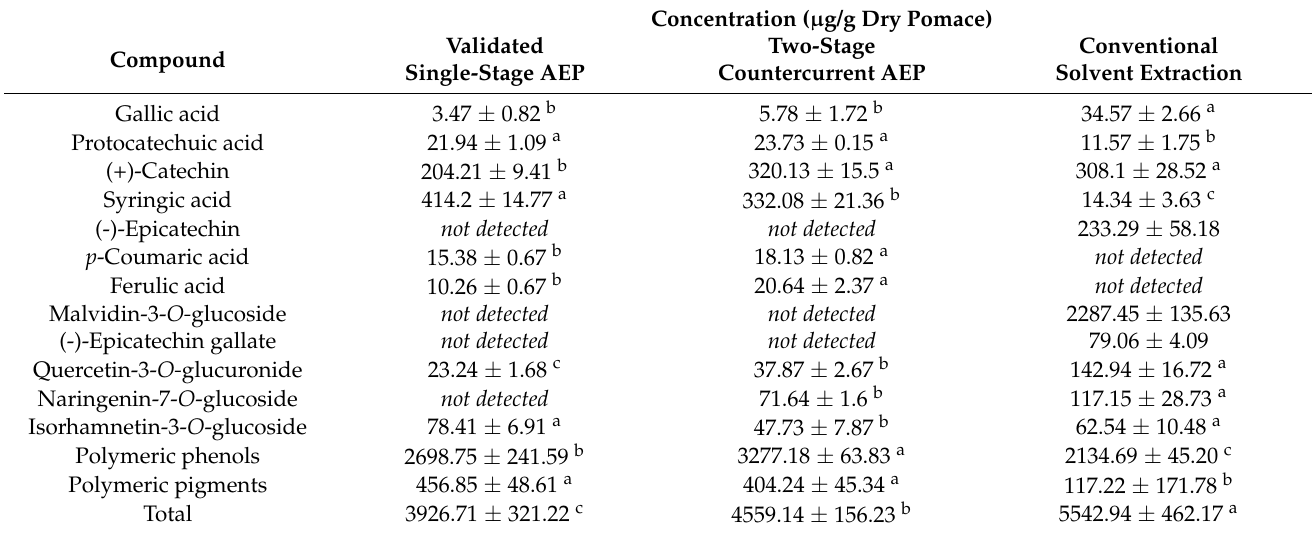
Table 3. Concentration ( µ g/g dry pomace) of phenolic compounds by RP-HPLC-DAD. Concentration ( µ g/g Dry